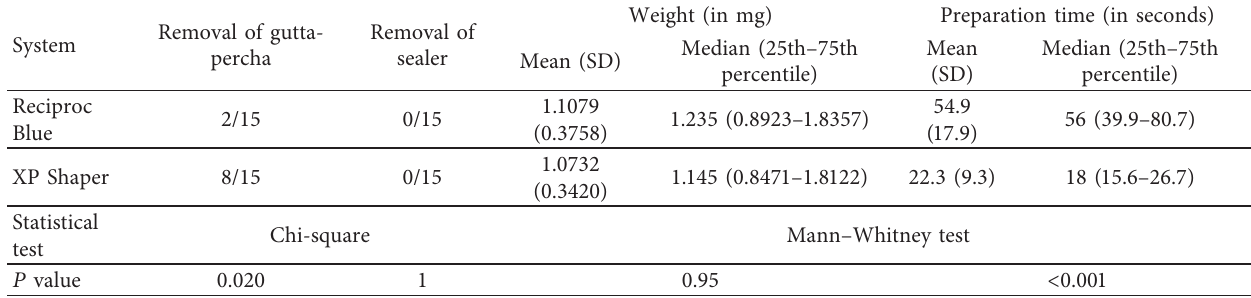
Table 1: Removal of obturating materials and mean (SD) and median (25th–75th percentile) of the weight of apically extruded debris and preparation time in the tested